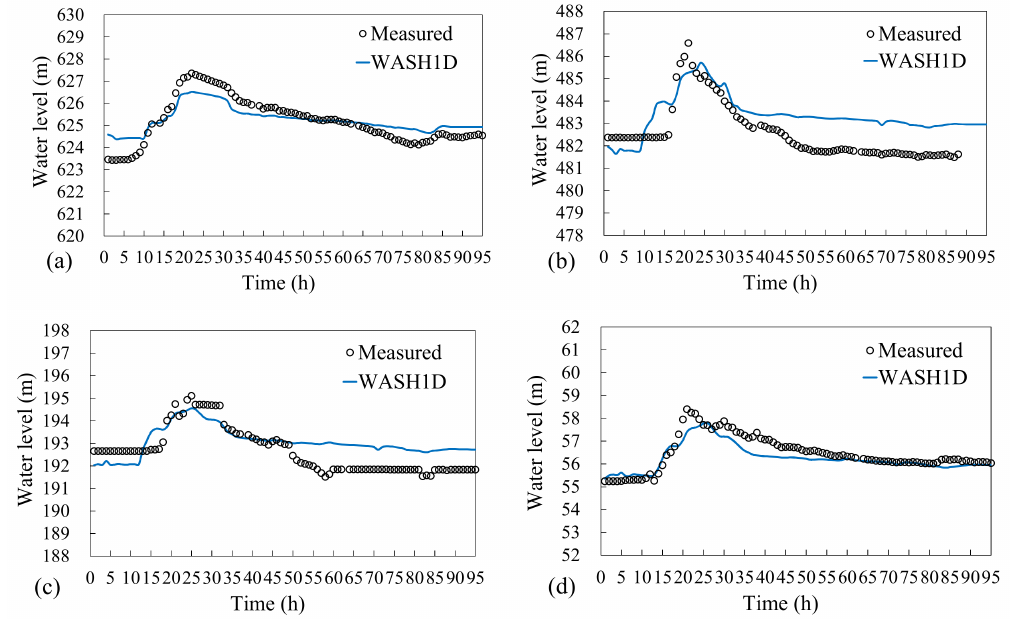
Figure 8. Comparisons of the measured and simulated water levels at ( a ) Xiangbi, ( b ) Shuangqi, ( c ) Yili, and ( d ) Dadaian gauging stations for Typhoon Soulik (July